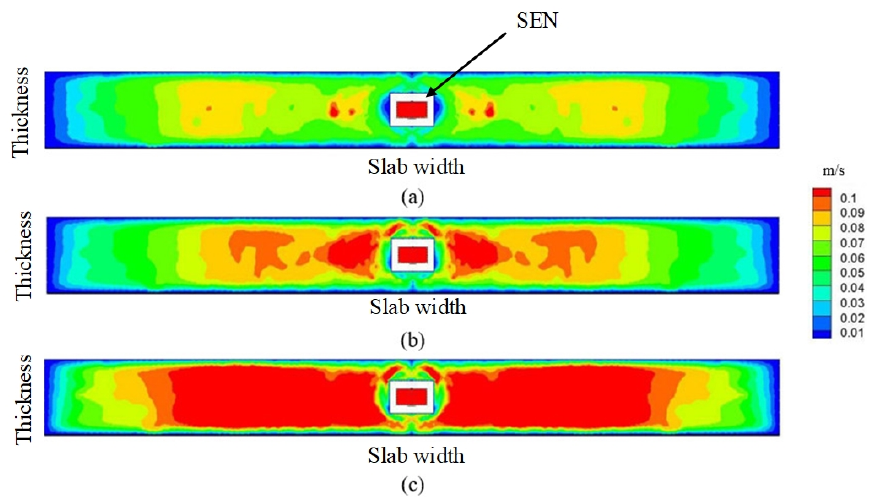
Figure 4. Velocity distribution of the free surface of the slab section under different velocities. ( a ) 0.6 m/min; ( b ) 0.8 m/min; and ( c ) 1.0 m/min.